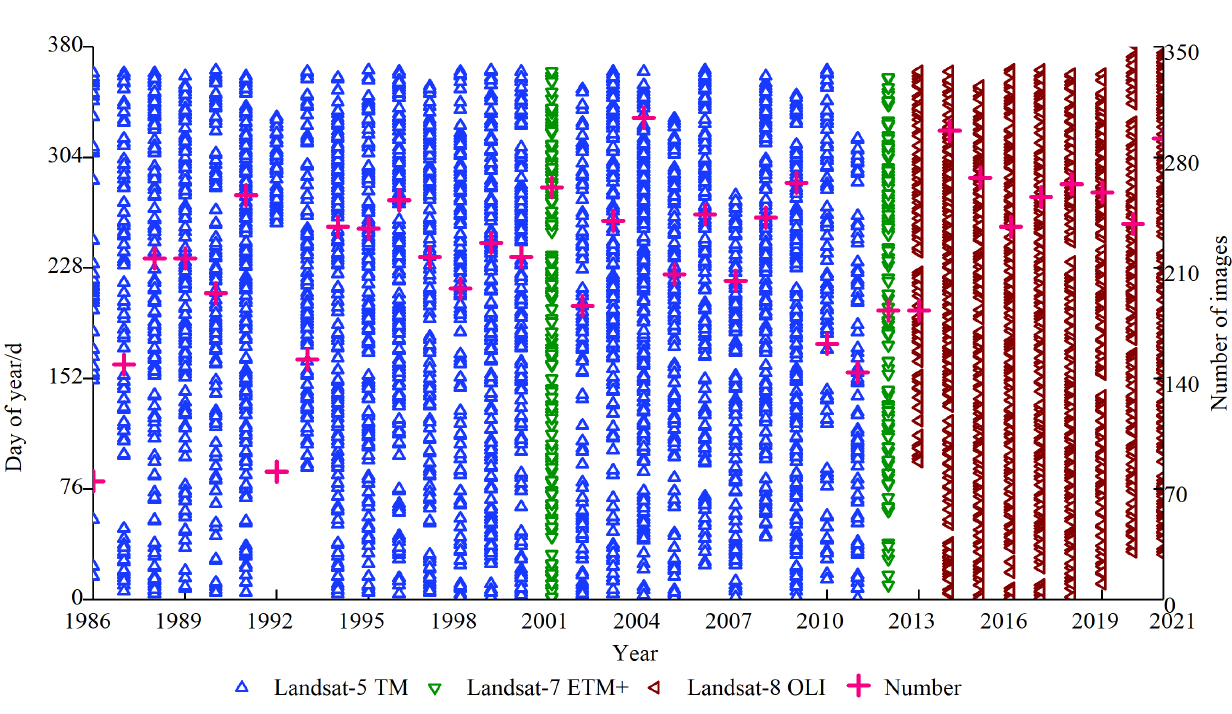
Figure 2. Landsat-series remote-sensing data used in this paper.